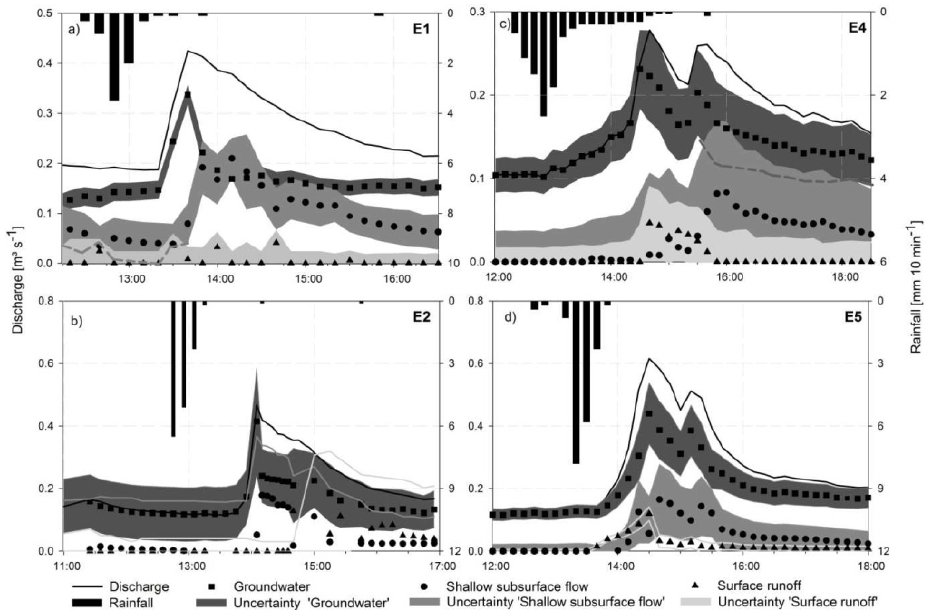
Fig. 8. Results of the three-component hydrograph separation and uncertainty bands for the monitored events: (a) E1 (28 September 2007), (b) E2 (9 October 2007), (c) E4 (22 August 2009), and (d) E5 (15 September 2009). Uncertainty is depicted with lines or areas, depending on overlay and